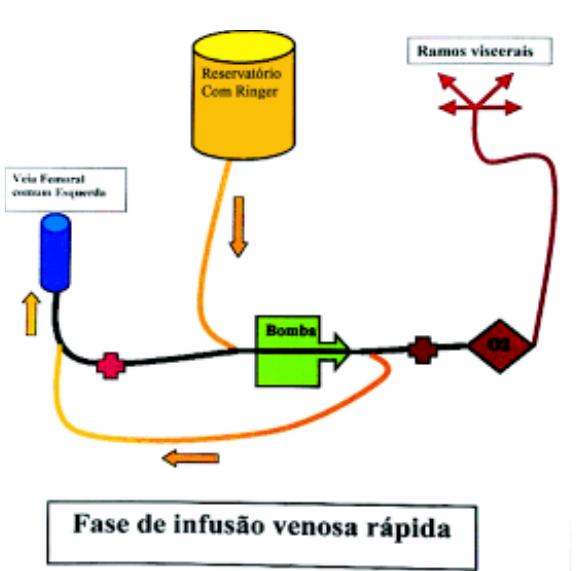
Fig. 2 - Em amarelo, o reservatório de cardiotomia e a linha de conexão no circuito contendo RL. As setas em amarelo indicam o sentido do fluxo. Em azul, a cânula venosa inserida na veia femoral esquerda, com linha de conexão à bomba centrífuga (verde) e ao oxigenador (vermelho). Note que nesta fase a linha de aspiração da veia femoral está pinçada e também a linha de conexão bomba- oxigenador (cruz